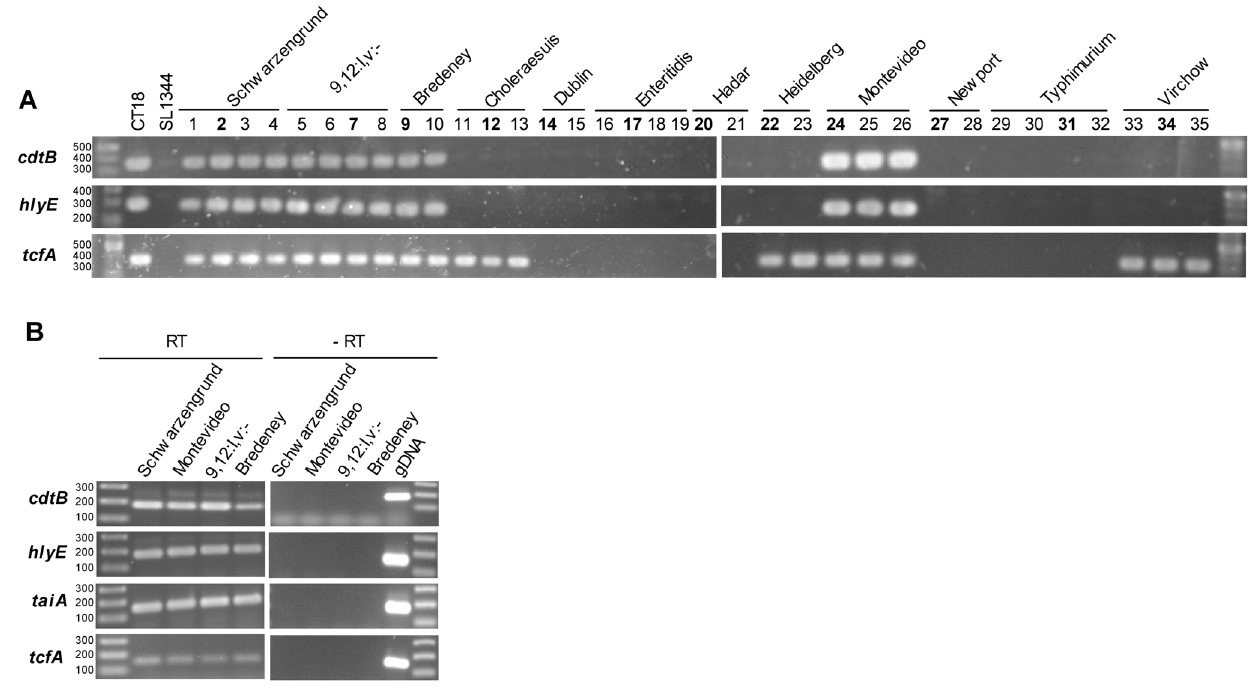
Figure 2. Presence and expression of typhoid-associated virulence factors among NTS serovars. (A) PCR analysis was used to confirm CGH results and to determine the distribution of three typhoid-associated genes in 35 clinical isolates from the 12 NTS serovars. PCR amplicons of 353-bp, 294-bp, and 335-bp indicate the presence of cdtB , hlyE and tcfA , respectively. Tested isolates are numbered from 1–35 according to Table S1, with the isolates that were characterized in mice and subjected to CGH analysis in bold. S. Typhi CT18 (CT18) and S. Typhimurium SL1344 (SL1344) were used as positive and negative controls, respectively. (B) Reverse transcription-PCR was applied to examine expression of cdtB , hlyE, taiA and tcfA genes in serovars Schwarzengrund, Montevideo, 9,12:l,v:- and Bredeney. Bacterial RNA was extracted from Salmonella cultures grown to late logarithmic phase in LB, followed by treatment with DNase I and reverse transcription. cDNA was used as template for PCR amplification using the primers listed in Table S2. Salmonella RNA without a reverse transcriptase treatment (-RT) and purified gDNA were used as negative and positive controls, respectively.